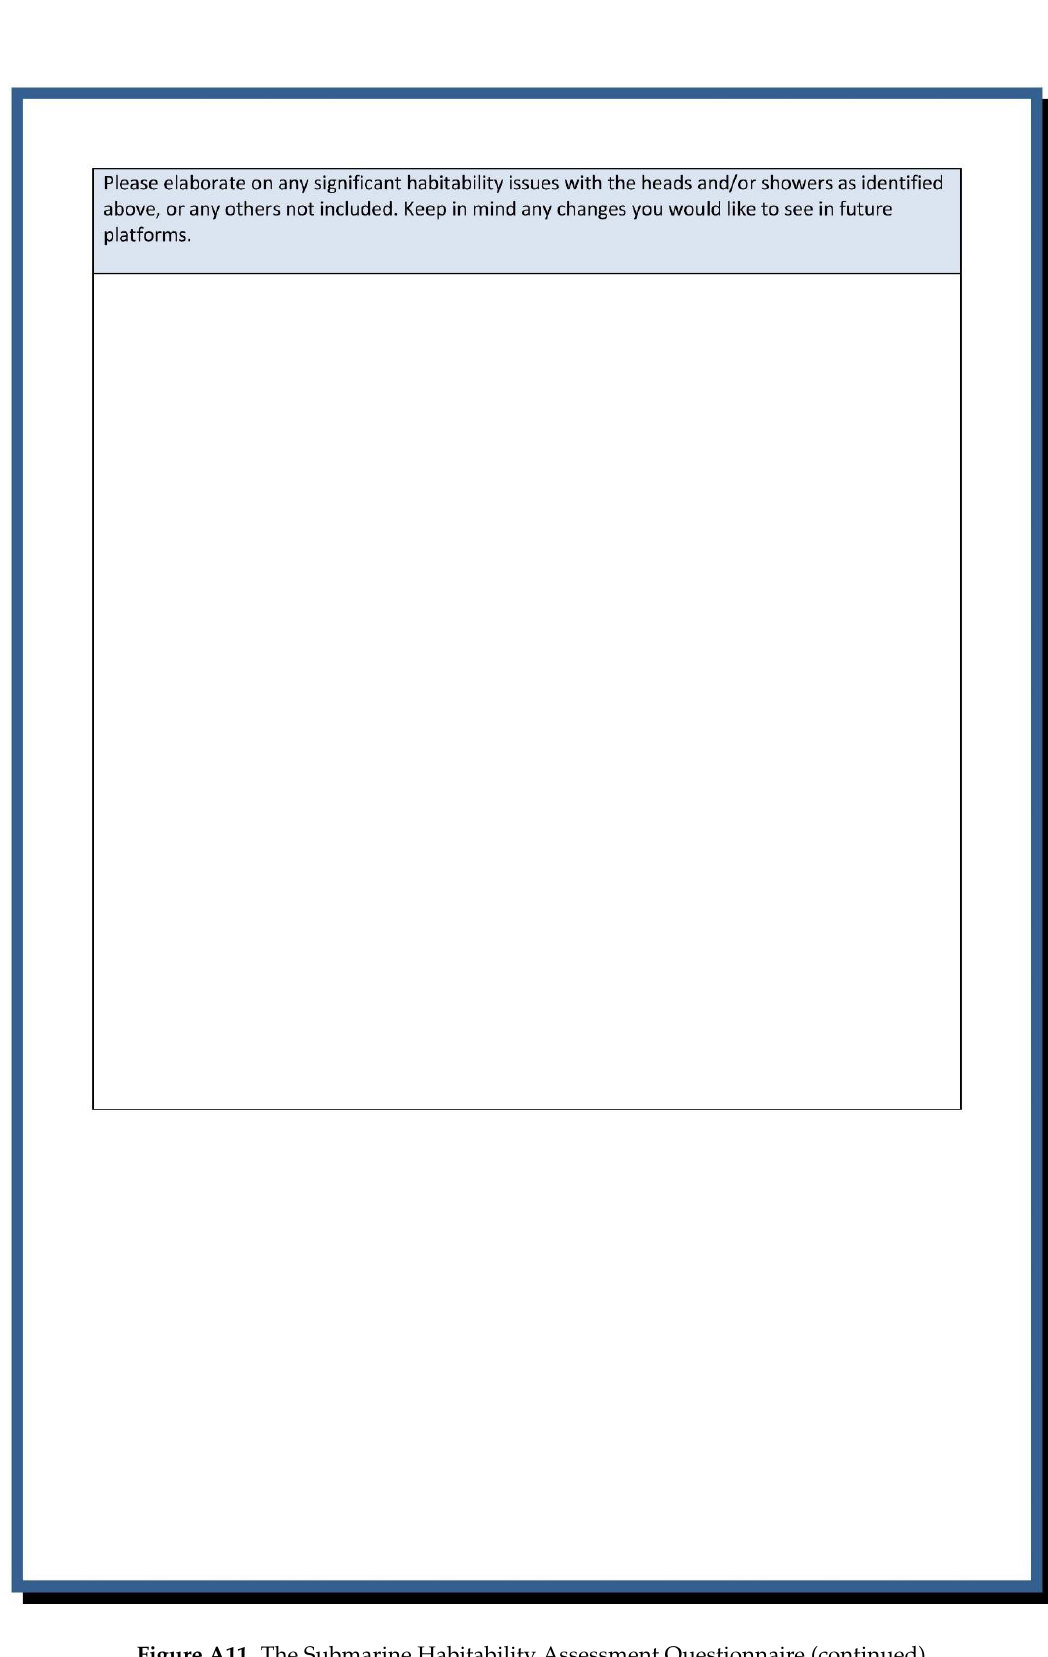
Figure A11. The Submarine Habitability Assessment Questionnaire (continued).